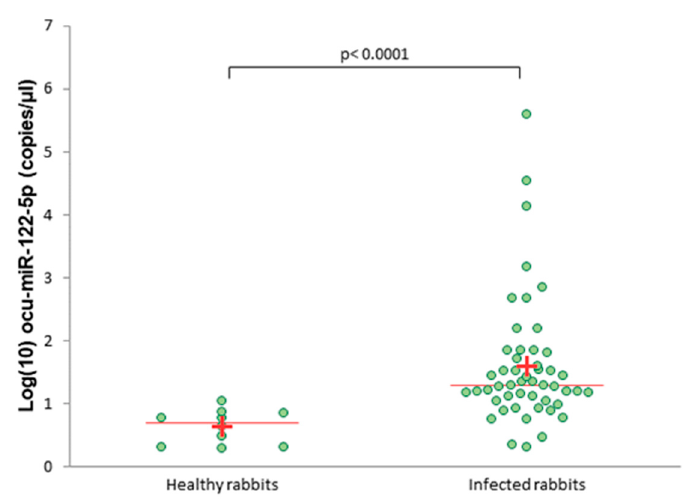
Figure 2. Absolute levels of serum ocu-miR-122-5p in healthy and infected rabbits measured by droplet digital PCR (ddPCR). A plus ( + ) indicates the average; a line indicates the median. The expression level of ocu-miR-122-5p in the serum was significantly higher in both infected groups—I1 (shorter survival time) and I2 (longer survival time)—compared to the healthy rabbits ( p <